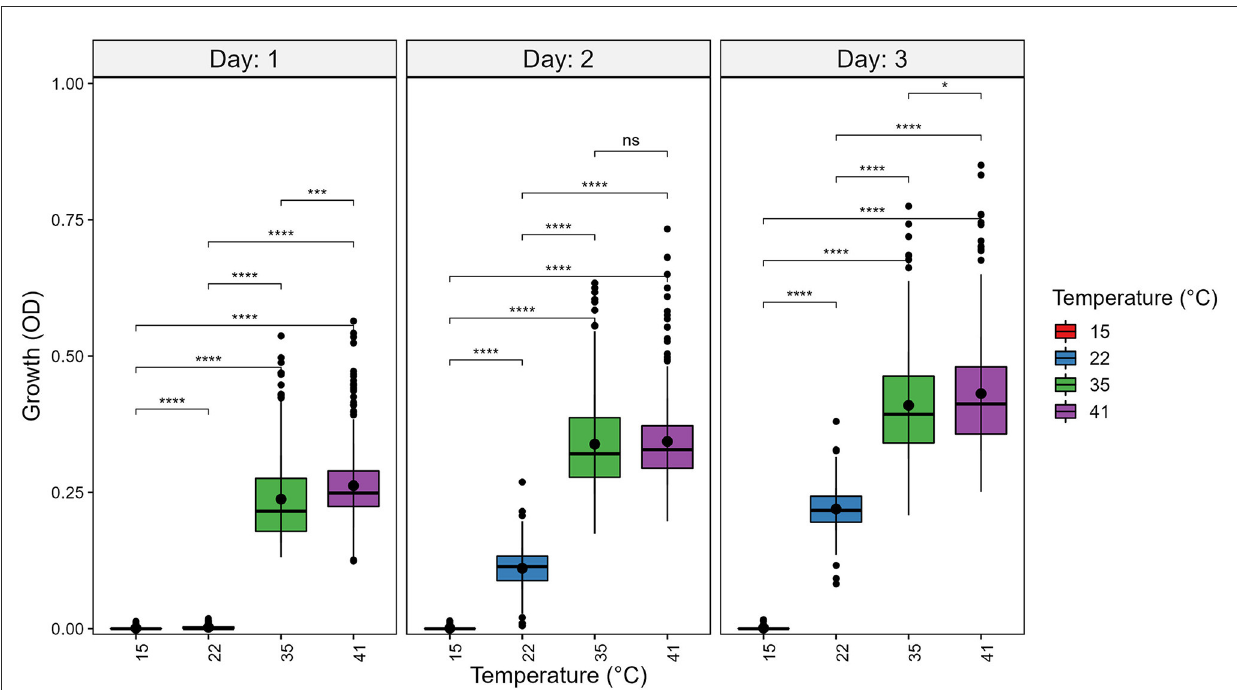
FIGURE2 Temperature significantly contributes to growth differences among strains of A. fumigatus . A. fumigatus strains were grown at four temperatures: 15 ◦ C, 22 ◦ C, 35 ◦ C, and 41 ◦ C during a 3-day period. To quantify growth, the optical density (OD) at 600nm of each strain was measured. Significance was determined through pairwise t -tests with post hoc correction via Holm’s method. Boxplot center line represent the median and the top and bottom represent interquartile range. * p -value < 0.05, *** p -value < 0.001, **** p -value <